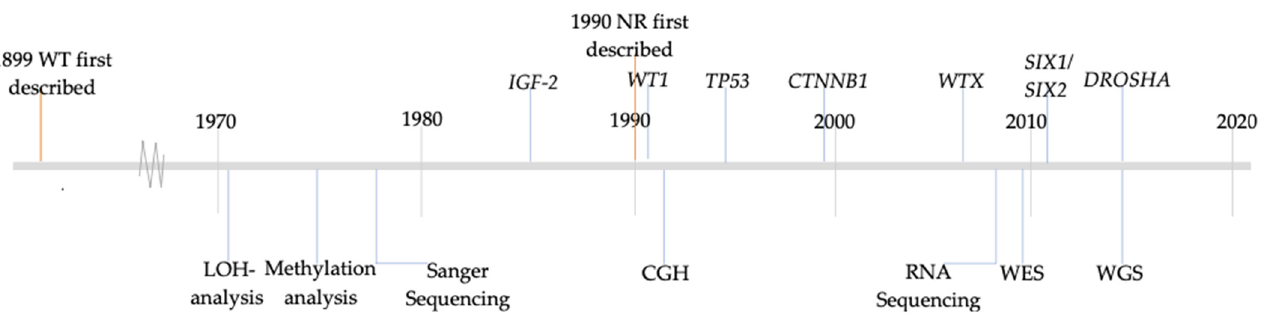
Figure 3. History of identified aberrations in WT and introduction of molecular methods. The above timeline shows selected WT-associated genes and there first description in relation to WT. The lower part indicates the year of the first description of the selected molecular methods. LOH , loss of heterozygosity; CGH , comparative genomic hybridization; RNA , ribonucleic acid; WES , whole exome sequencing; WGS , whole genome